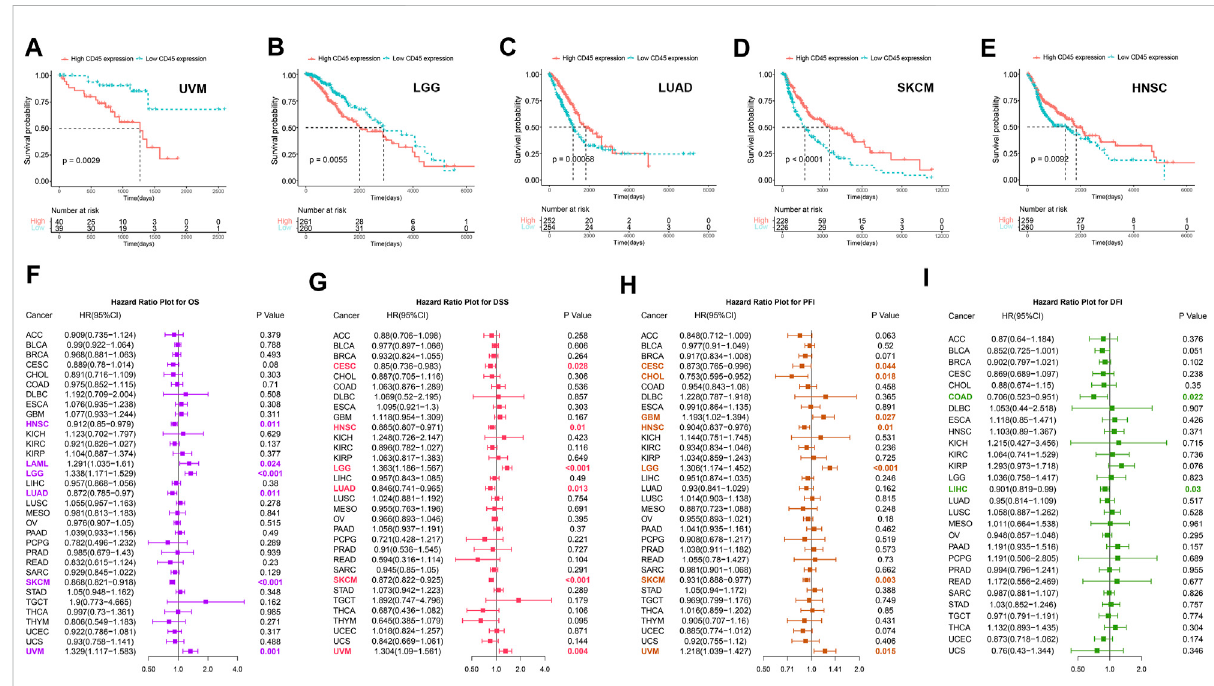
FIGURE 3 Analysis of the prognostic value of CD45 across different cancers. Survival curves plotted by the Kaplan-Meier method in UVM (A) , LGG (B) , LUAD (C) , SKCM (D) and HNSC (E) between thehighandlowCD45 expression groups. ThevalueofCD45expression andOS (F) ,DSS (G) ,PFI (H) and DFI (I) prognostic factors assessed by univariate Cox regression